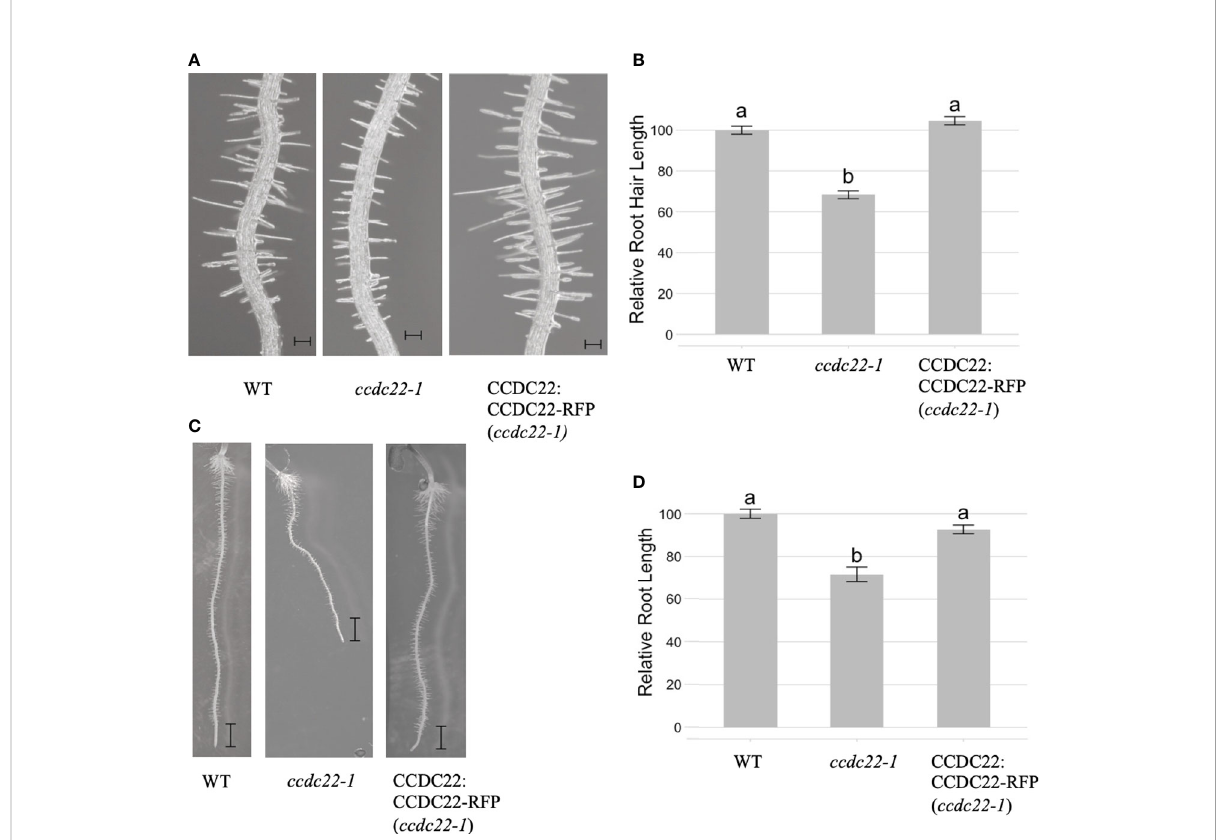
FIGURE 6 CCDC22 is required for root and root hair growth in Arabidopsis seedlings. (A) Images of the root hairs of fi ve-day old wild type, ccdc22-1 and CCDC22:CCDC22-RFP (ccdc22-1) seedlings grown on 1X MS media, Scale bars are equal to 100 mm. (B) Relative root hair lengths of the indicated genotypes as compared to wild type (WT). Represented is the combined data from three independent experiments in which 15 root hairs per seedling and 10 seedlings per genotype were measured. (C) Expression of a C-terminal RFP fusion to CCDC22 in the ccdc22-1 background resulted in complementation of the ccdc22-1 short root phenotype. Scalebars are equal to 1mm. (D) Relative root growth (%) of the indicated genotypes. Letters above the bars represent statistically signi fi cant groupings at the level of p < 0.001 as determined by analysis of variance (ANOVA) and Tukey ’ s honestly signi fi cance difference